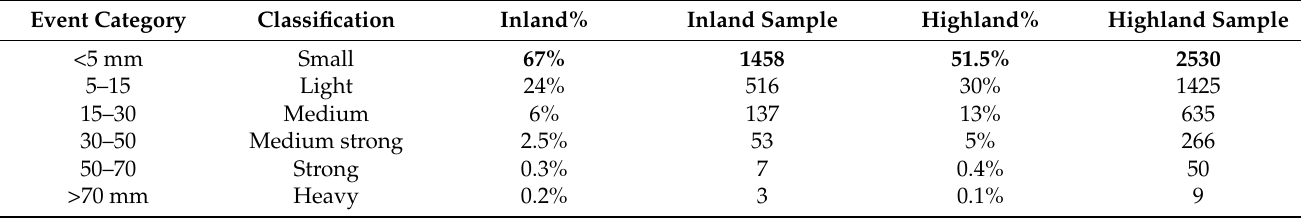
Table 5. Classification of precipitation events from all stations (12 stations) in the Barada Basin between 2010 and